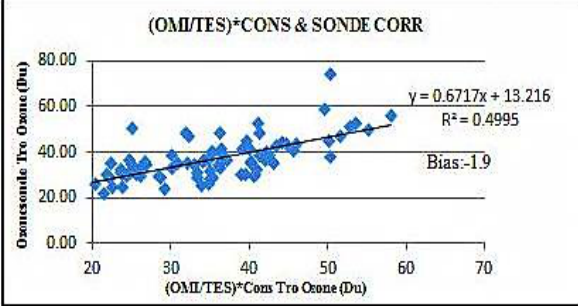
Figure 14 - Correlation of tropospheric ozone* Cons (OMI / TES) and Ozonesonde in urban